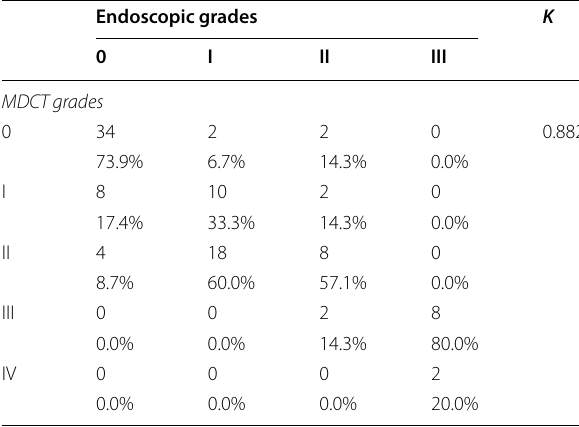
Table 5 Results of MDCT assessment of porto systemic collaterals in EV of the study patients ( N